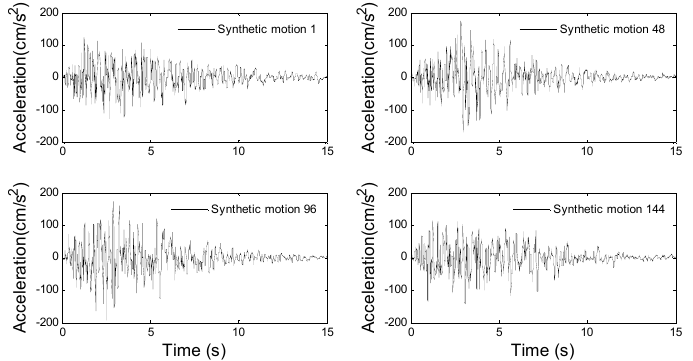
Figure 1. Four typical acceleration time histories generated in the present study.